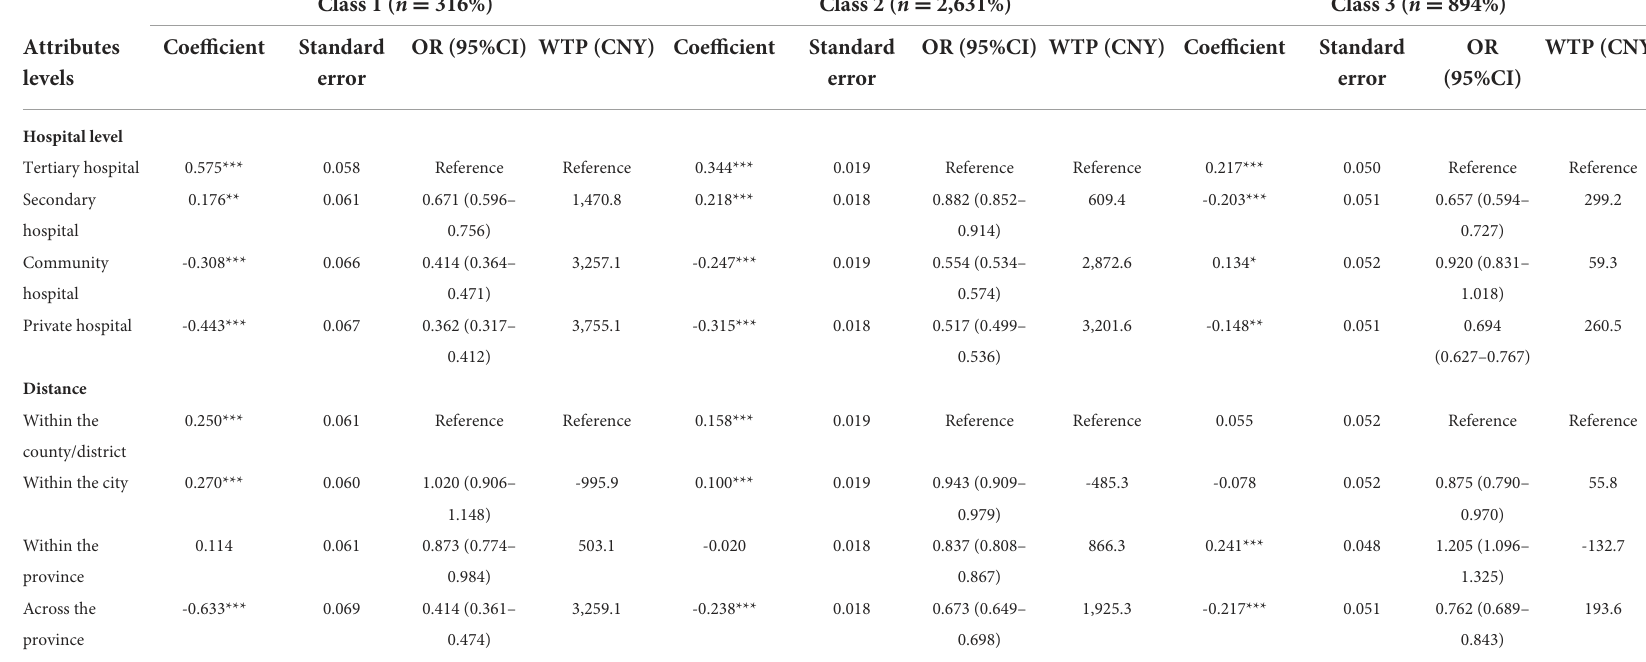
TABLE 8 Attributes and levels of chronic non-infectious diseases